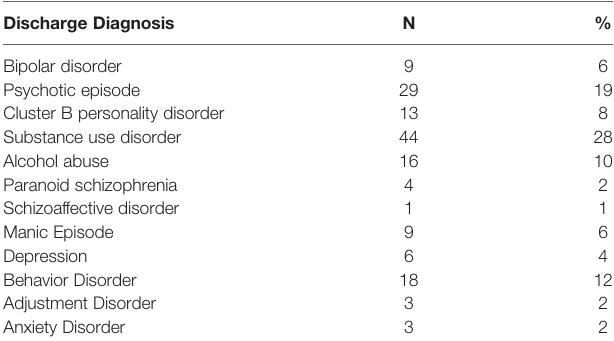
TABLE 4 | Discharge